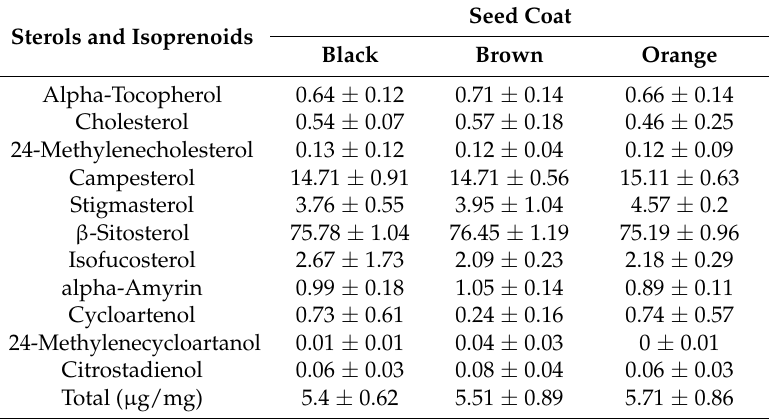
Table 4. Phytosterol and Isoprenoid Composition of Arachis hypogaea Seed Coats of Different Classes.